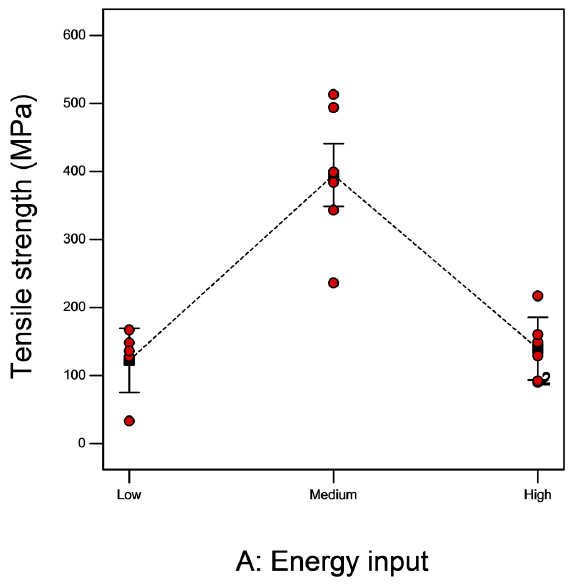
Figure 12. Effect of energy input on tensile strength.